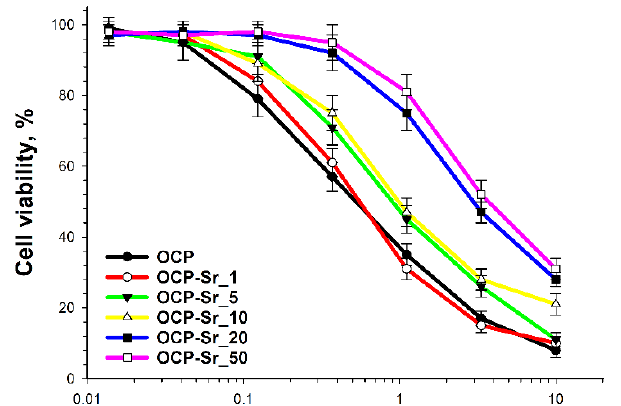
Figure 5. Viability of C3H/10T1/2 cells after 96 h of co-incubation with native OCP without strontium substitution for calcium (OCP) and Sr-substituted OCP (OCP-Sr) with varying degrees of sub- stitution.